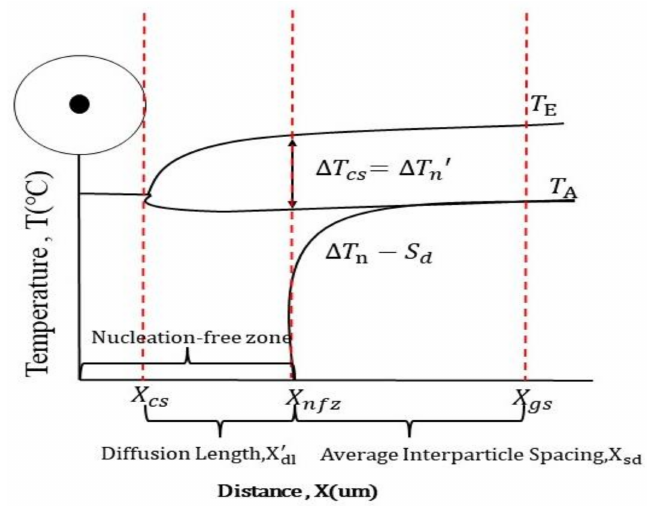
Figure 2. Scheme was simplified to show the intersection between the actual temperature T A and the ∆ T n − S d curve indicating the location of the nucleation event, and the three regions that together establish the grain size of the microstructure: x cs , x (cid:48) and x sd .The first two regions x cs and x (cid:48) represent dl dl a nucleation-free zone, where nucleation is not possible for the particle distribution described by ∆ T ∆ T (cid:48) n − S d . n is the difference between the actual temperature in the melt. Figures taken from Acta Materialia [34] with permission.